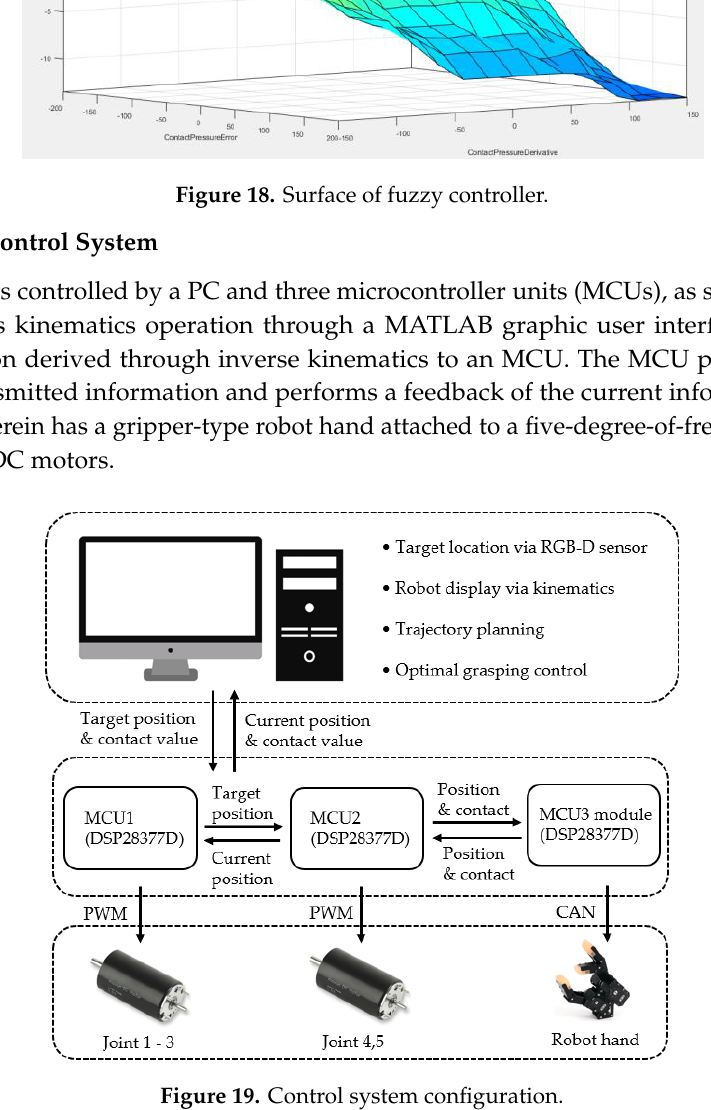
Figure 17. Optimal torque MFs.